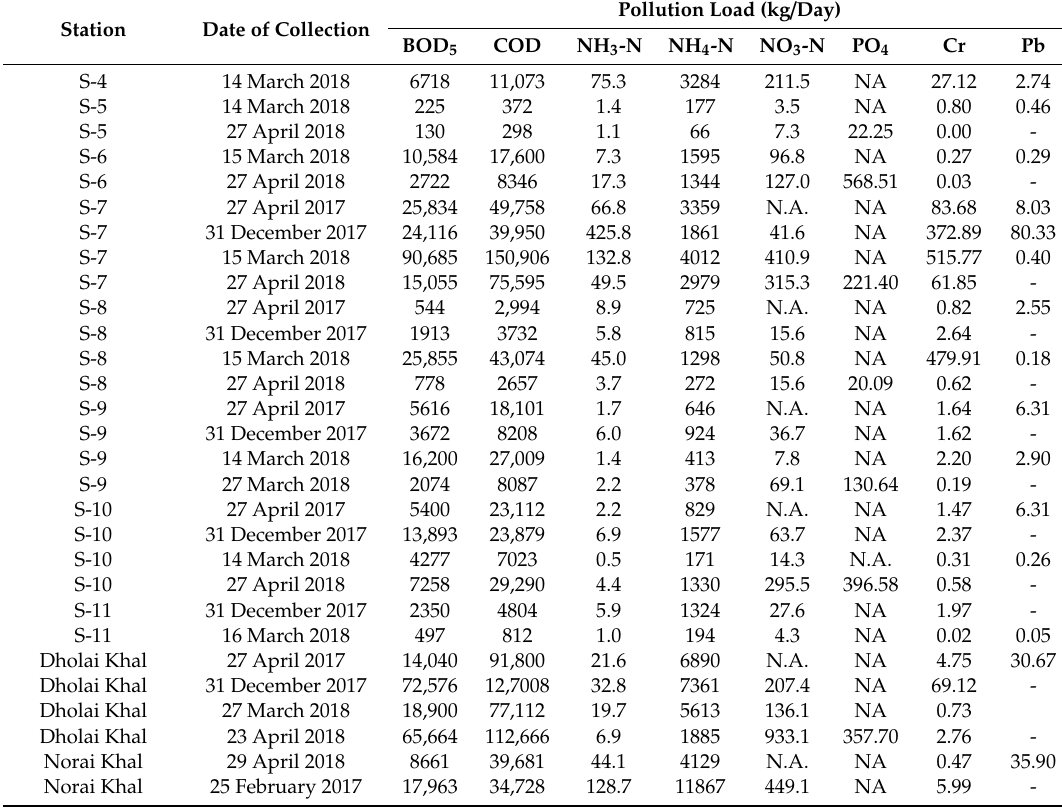
Table A4. Pollution loads of other wastewater